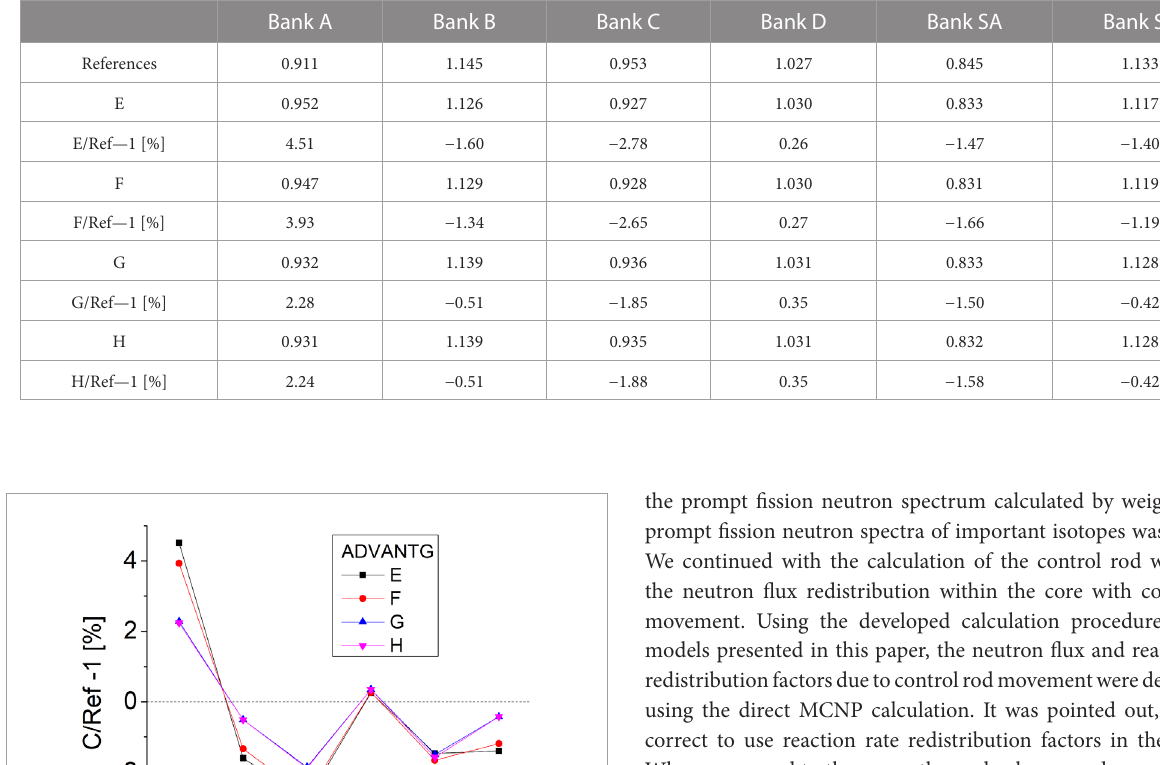
TABLE6 ReactionrateredistributionfactorsusingadjointneutronfluxdistributionfromADVANTG/Denovocalculation,comparedtothereferencedirect MCNPcalculation.